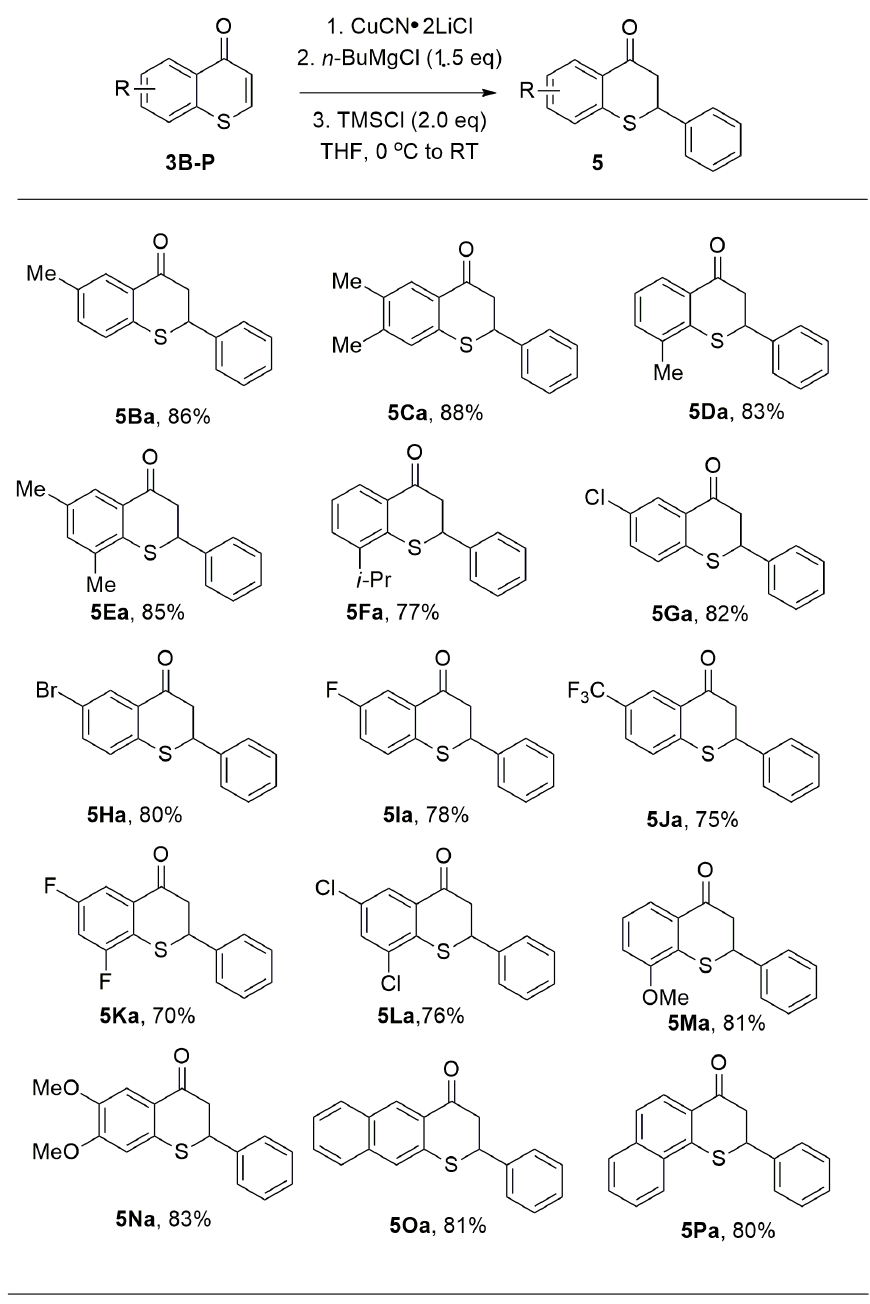
Figure 8. Synthesis of thioflavanones.